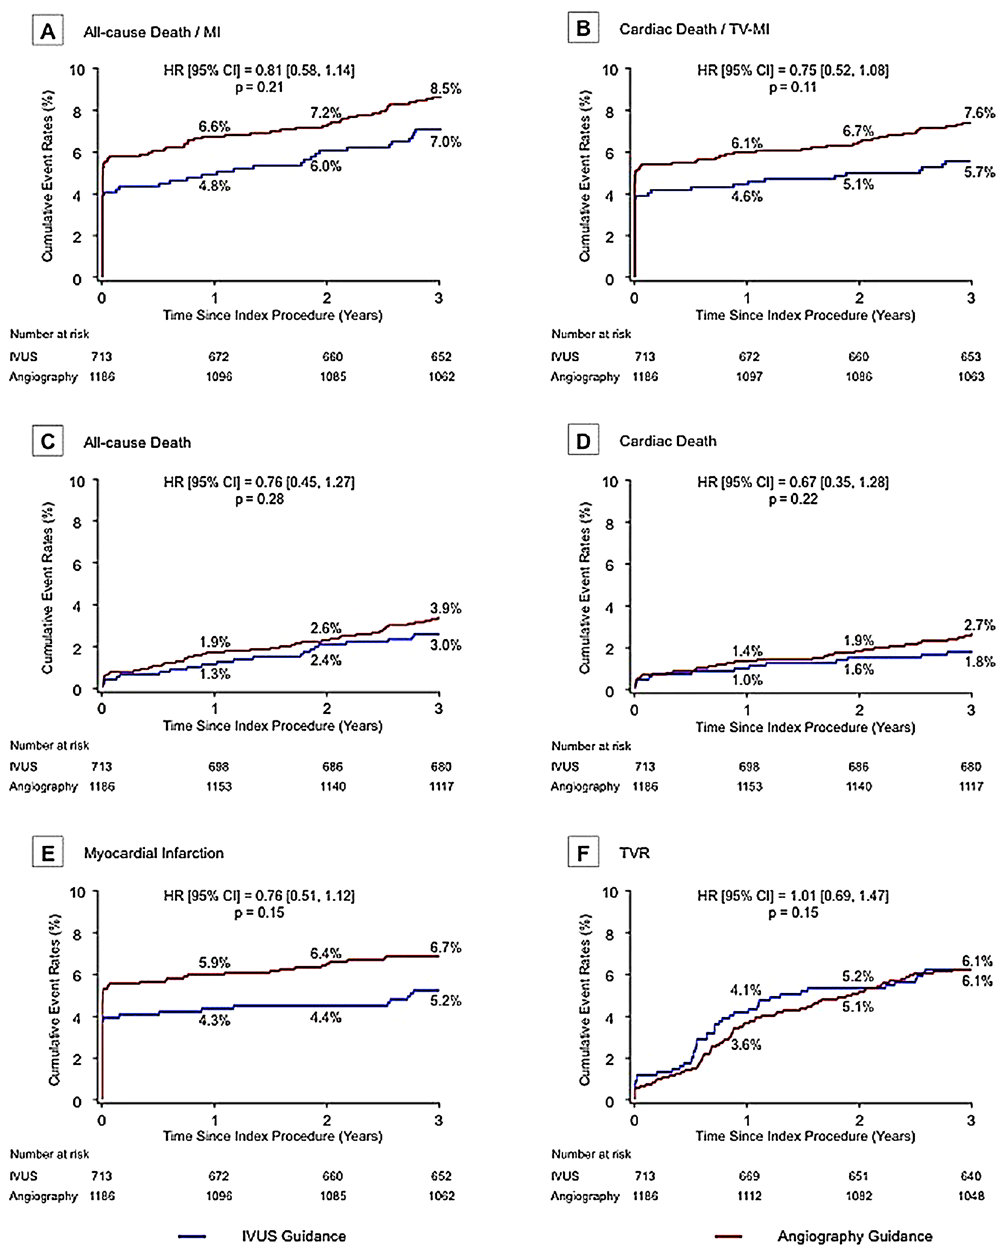
Figure 2. Unadjusted Kaplan-Meier Curves of 3-Year Outcomes. The HRs were reported for patients with IVUS guided versus those without IVUS guided. CI = confidence interval; HR = hazard ratio; TV-MI = target vessel myocardial infarction; TVR = target vessel revascularization; other abbreviations as in Fig.